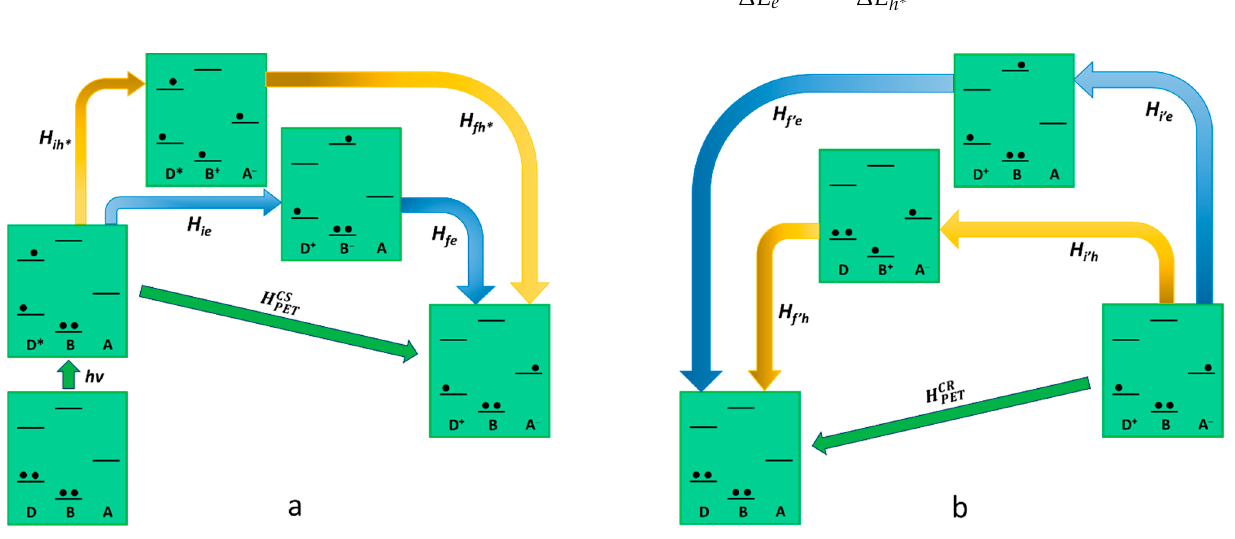
Figure 2. Schematic representation of oxidative photoinduced electron transfer in D-B-A dyads, according to superexchange. The states involved in the mechanism (virtual states pathways are described with blue and yellow arrows) are represented in terms of electronic configurations. On the left ( a ) (photoinduced) charge separation is described while charge recombination is shown on the right ( b ).